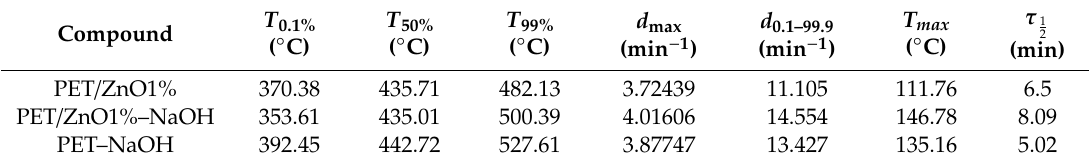
Table 3. Thermodynamic and kinetic parameters of decomposition computed from TG scans.